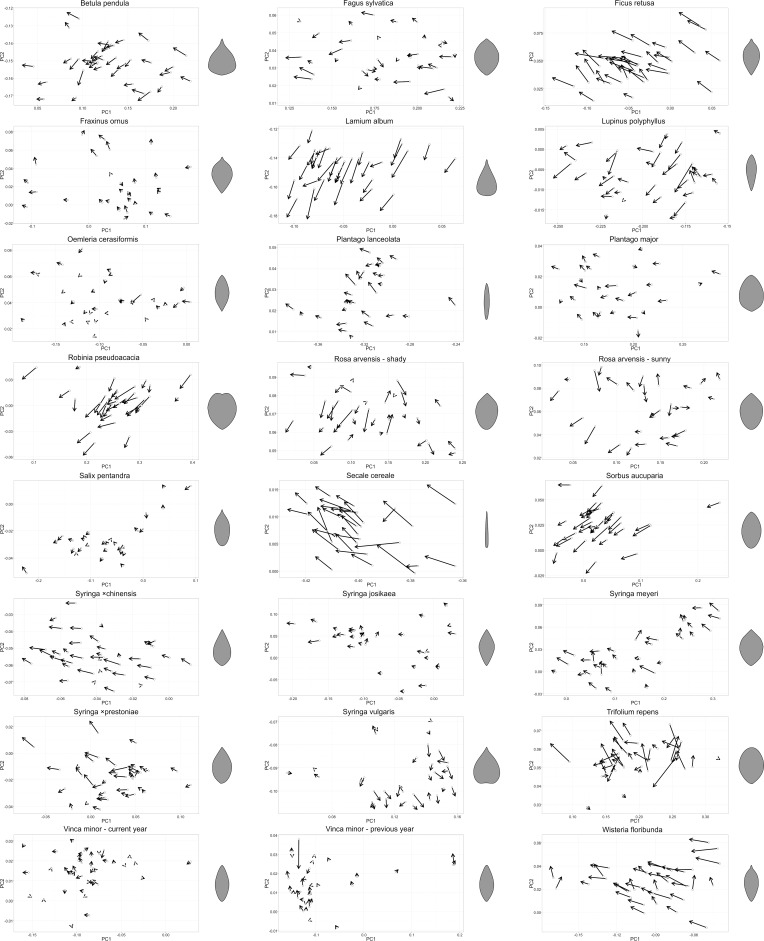
Shape changes resulted from principal component (PC) analysis of elliptic Fourier descriptors for fresh and dried leaves for each group of analysed plants.Arrows represent shape changes in the PC1–PC2 space. The starting point indicates shape of a fresh leaf and its head corresponds to its shape after drying. Vector lengths are, in general, not comparable between diagrams, as their scaling is not identical. Leaf silhouettes on the right present mean shapes of fresh leaves.